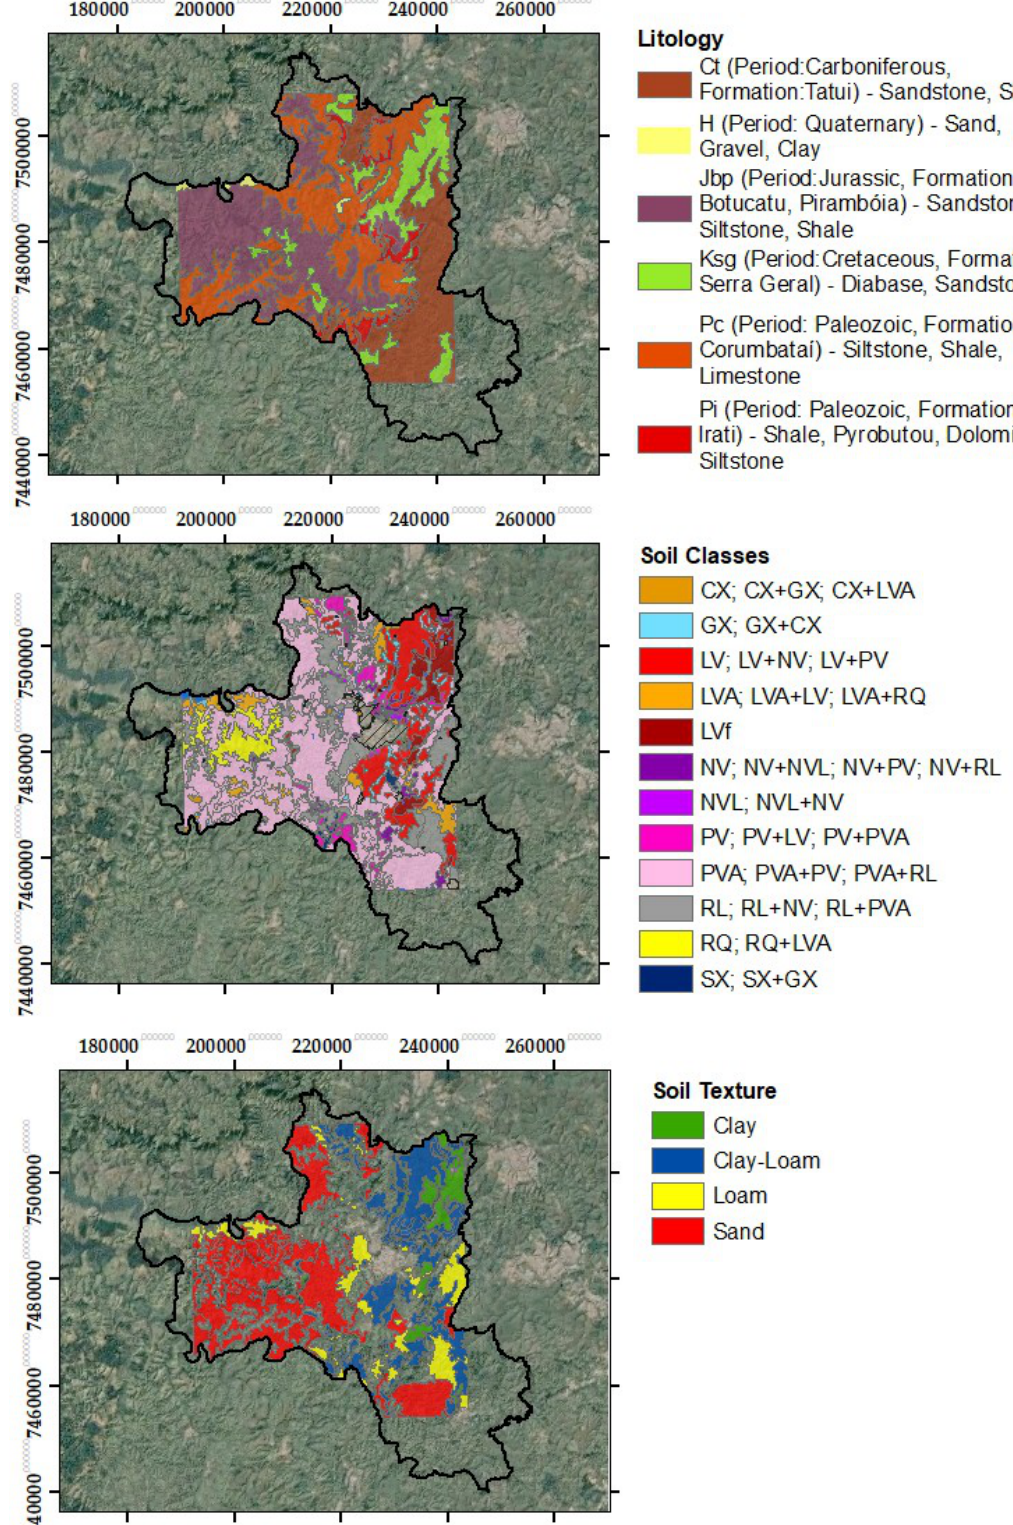
Figure 3. Legacy maps covering approximately 80% of the study site: ( a ) Geological map, 1:100,000 scale [26], ( b ) Soil map, 1:100,000 scale [25] according to the Brazilian Soil Classification System [28], ( c ) Surface soil textural classes based on the soil map.